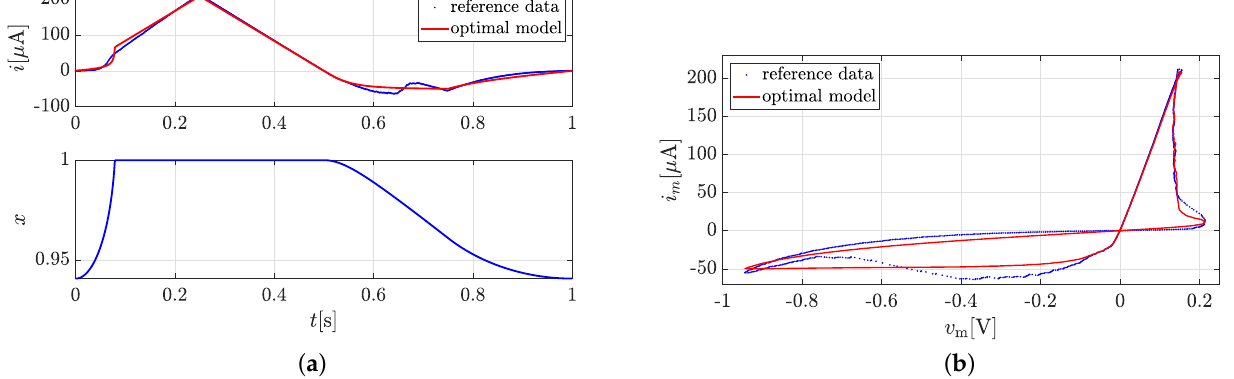
Figure 6. Optimization results obtained for the asymmetric Strukov model with rectangular window for the same reference data presented in Figure 5. F ( x ) = 5.8510 × 10 − 3 . ( a ) Comparison graph of the memristor current obtained from the model and the reference data, and the internal variable x ( t ) ; ( b ) Corresponding i m − v m